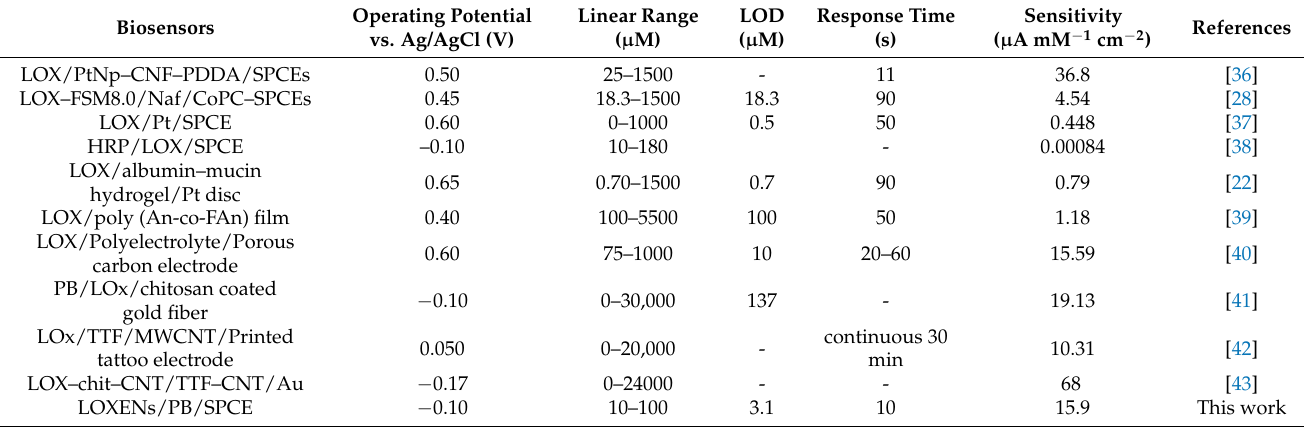
Figure 6. ( a ) Amperometric results of LOXENs/PB/SPCEs at − 0.1 V in 50 mM PBS (pH 7.4) with successive additions of lactate. ( b ) Fitting the Langmuir model to the current responses (measured 10 s after lactate addition) to a maximum of 1.6 mM lactate. Inset: Calibration curve for lactate concentrations up to 100 µM. ( c ) Lineweaver–Burk model fitting to the catalytic region using the current responses to lactate additions up to 1.6 mM (n = 4). Table 2. Comparison of the state-of-the-art analytical performance of various amperometric lactate